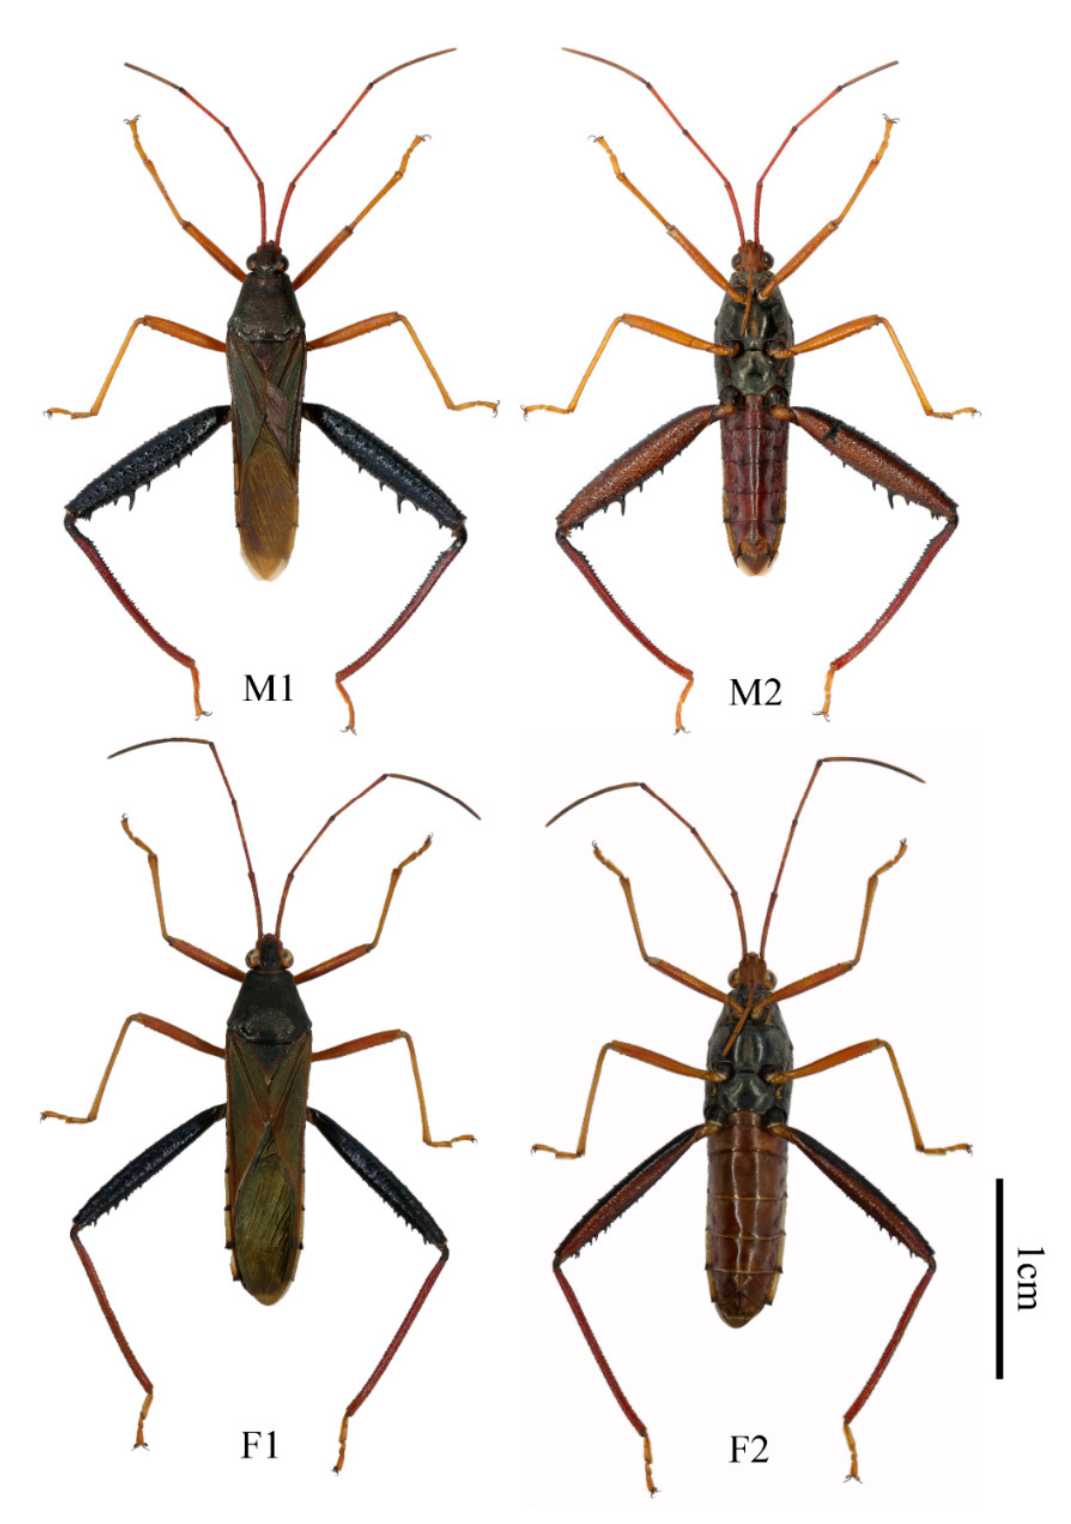
Figure 4. N. bispina sp. nov. M1 dorsal side of male M2 ventral side of male F1 dorsal side of female F2 ventral side of female.